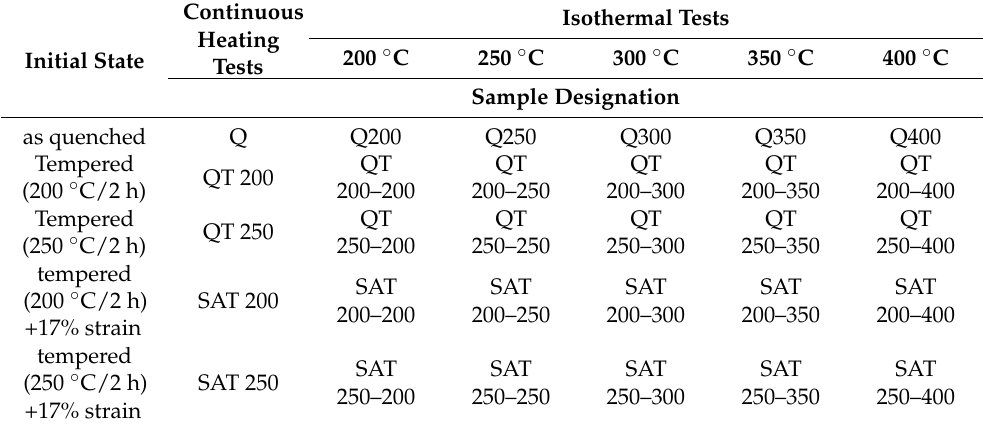
Table 6. The initial state of dilatometric samples studied with continuous heating and isothermal